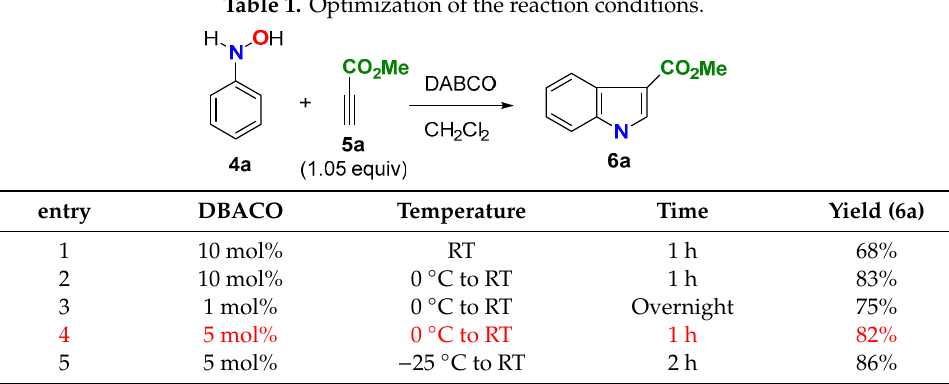
Table 1. Optimization of the reaction